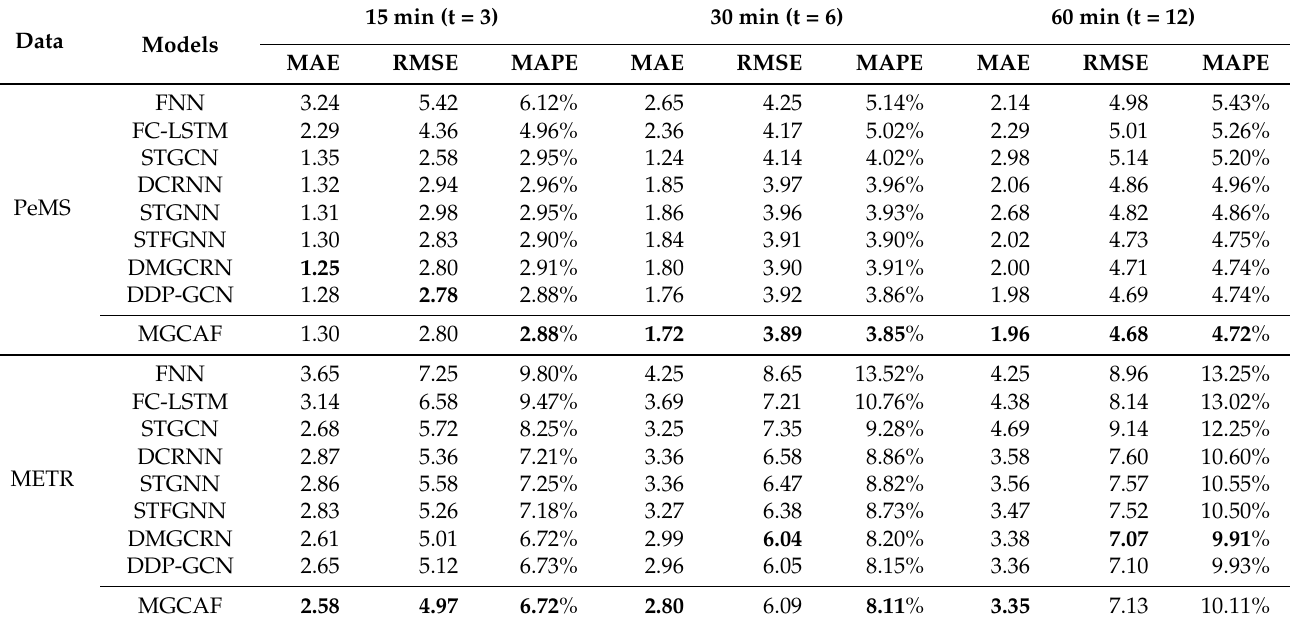
Table 2. The inference performance achieved by the MGCAF model and different baselines on two